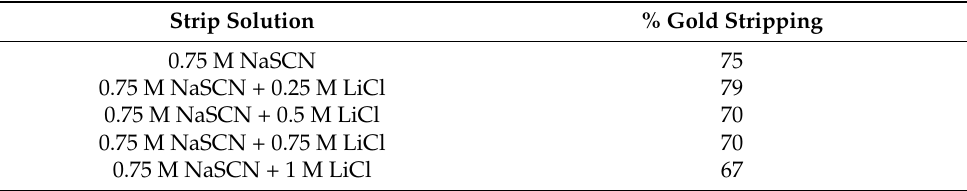
Table 9. Effect of LiCl concentration on gold